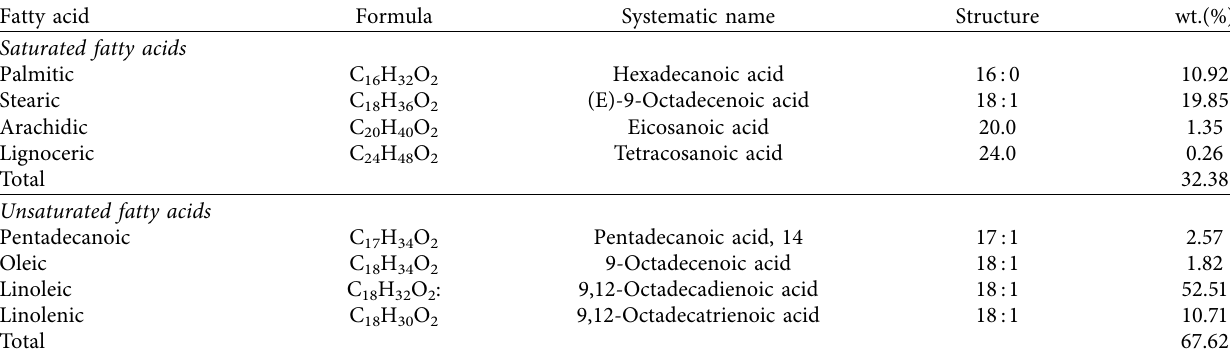
Table 3: Fatty acid composition of neem oil.